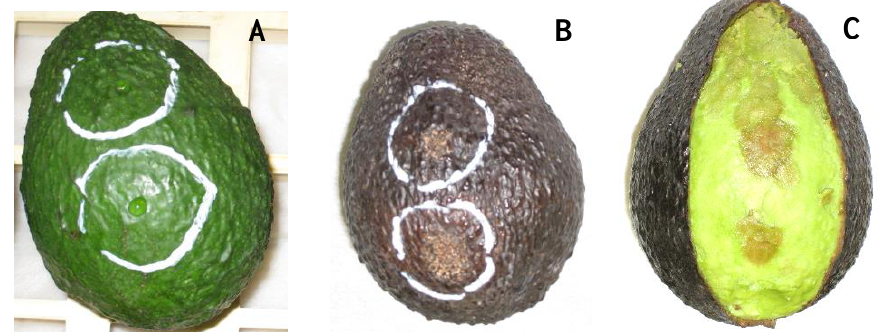
Figure 1. Avocado fruits (cv. Hass) immediately after inoculation ( A ), and external ( B ) and internal ( C ) anthracnose symptoms in control fruits at eating ripe stage.